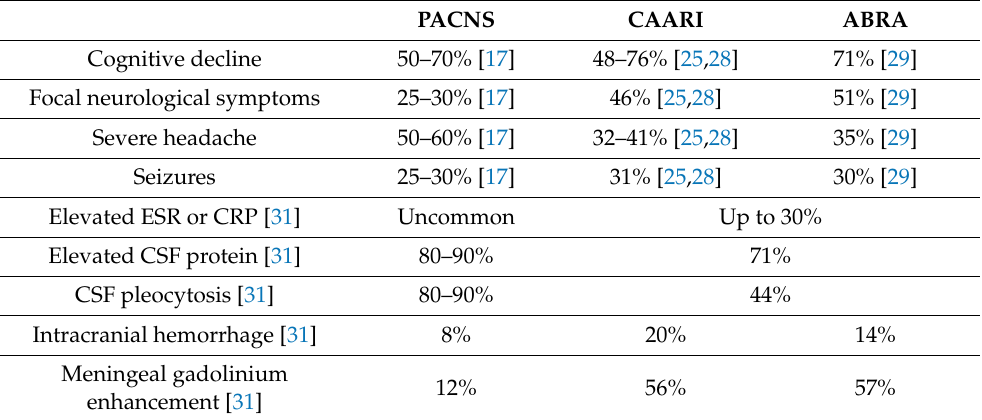
Table 3. The most common features of primary CNS vasculitides and their